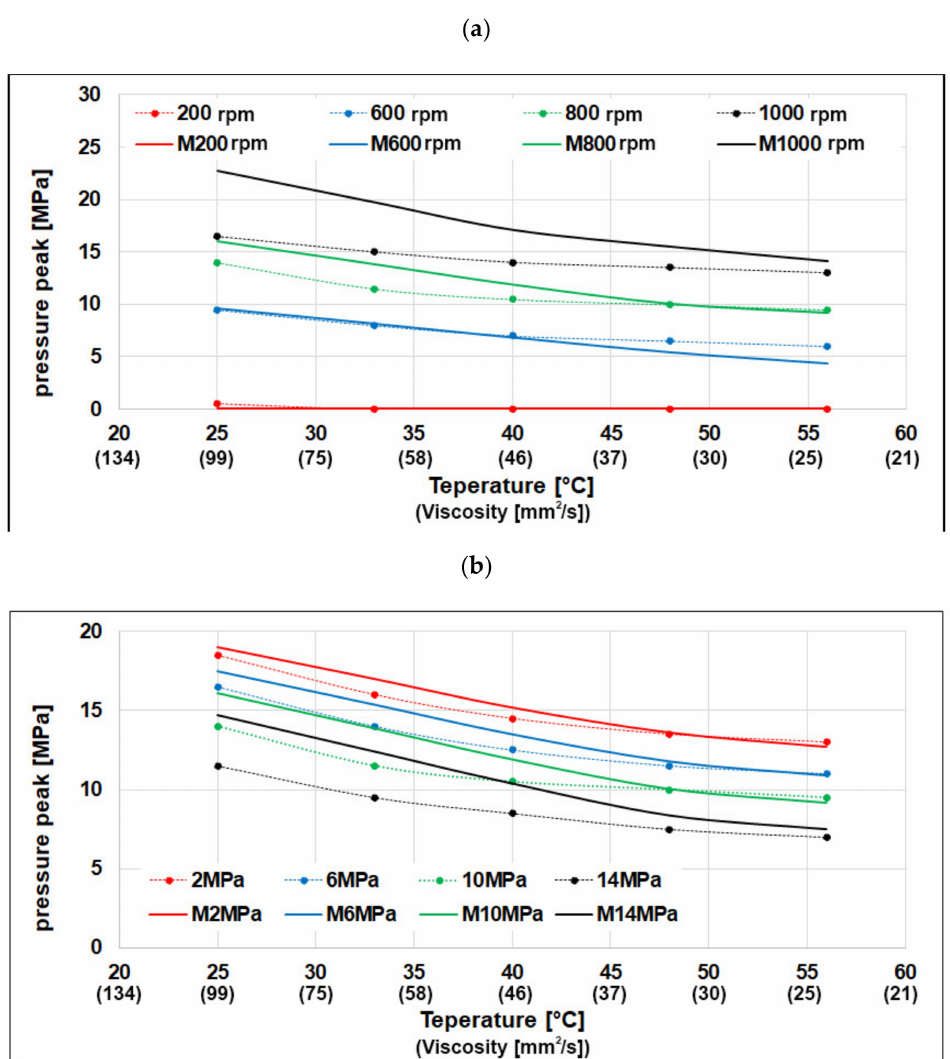
Figure 28. Comparison of the pressure peak values obtained for variable temperatures (viscosity) from the experiment and simulation: ( a ) obtained at a constant pumping pressure of 10 MPa, displacement setting of 20% and variable rotational speed; ( b ) obtained at a constant rotational speed, displacement setting of 20% and variable pumping pressure (experiment results are marked with a thicker solid line, and the simulation results are marked with a thinner dotted